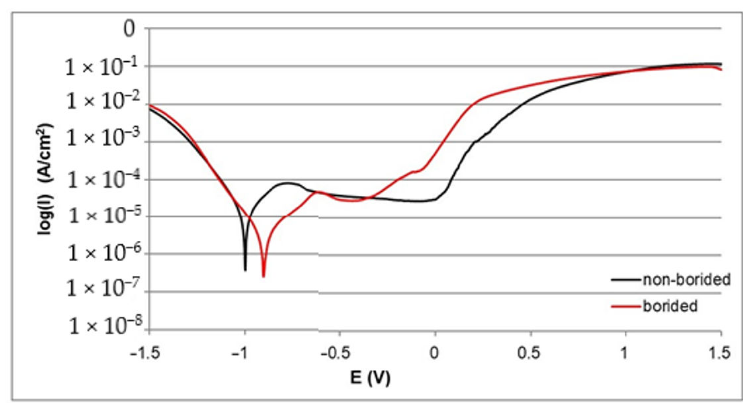
Figure 6. Polarization curves recorded during the corrosion resistance test in a 3.5% NaCl solution for borided and non-borided Nimonic ® 80